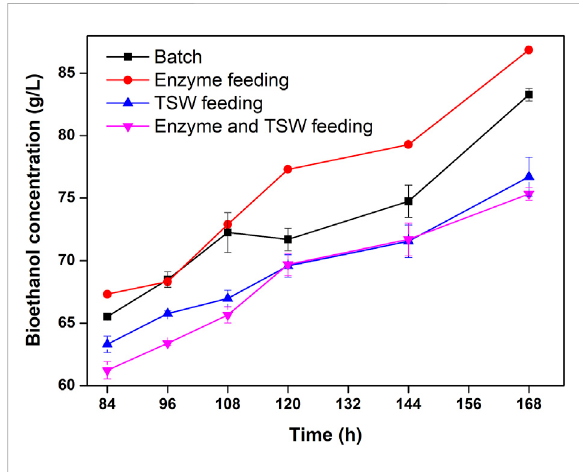
FIGURE 5 Time-course of ethanol concentration during SSCF under different feeding strategies with a feeding period of 48 h.